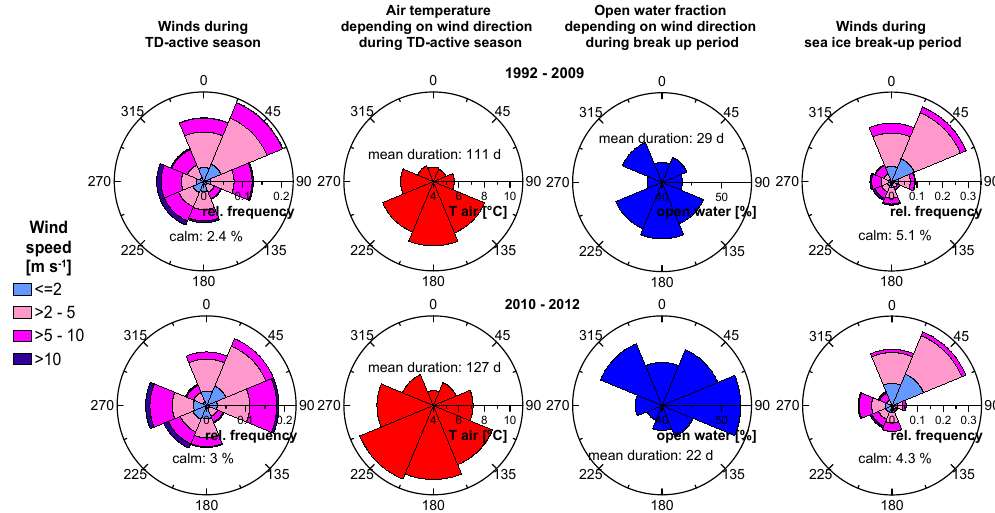
Figure 20. Wind charts and rose diagrams for the long-term reference time period (top row) and the current observation periods (bottom row). Left: wind speed and direction during days with mean daily positive air temperature ( T air ), defined as season available for TD to proceed. Right: wind speed and direction during sea ice break-up, defined as time period when open water fraction increases from 30 to 90%. Middle left and right: mean T air and mean open water fraction depending on prevailing wind direction during TD-active season and sea ice break-up, respectively. Note, although directed away from the erosive coastline, winds from the south also provide favourable conditions for coastal thermo-erosion through higher T air and enhanced sea ice export.